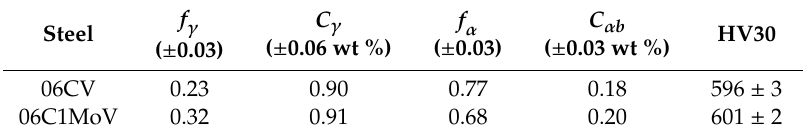
Table 4. Fraction and carbon content of retained austenite (f γ , C γ ) and bainitic ferrite (f ¦ obtained from XRD, and hardness results for the initial bainitic